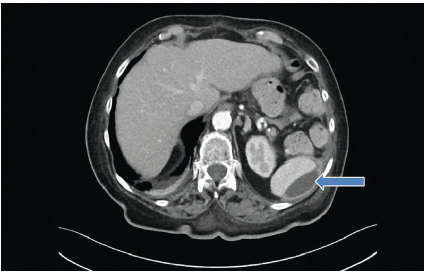
Figure 2: CT scan showing subcapsular fluid formation of the spleen as manifestation of septic herds in endocarditis.